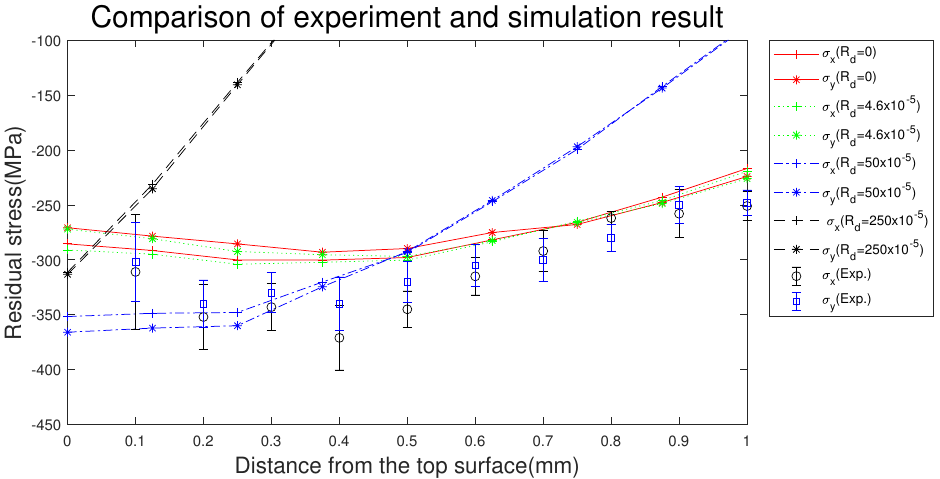
Figure 20. Residual stress comparison of the experiment and simulation result in the depth (z-)